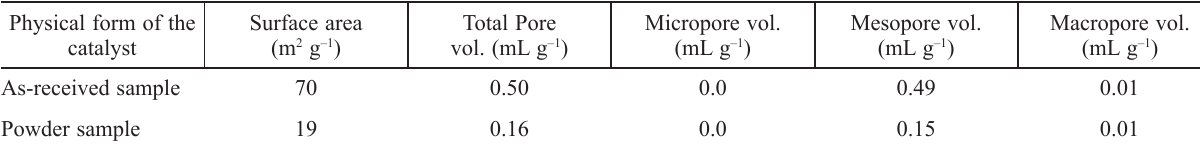
Table 4 – Surface area and various pore volumes of different forms of Amberlyst15 Physical form of the